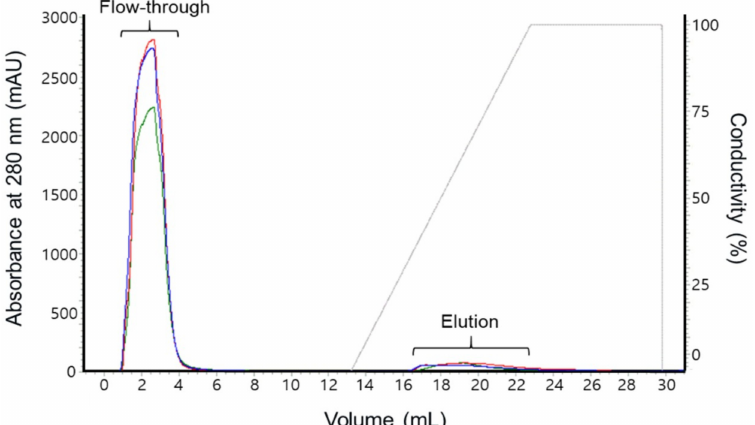
Figure 1. Chromatogram of heparin a ffi nity chromatography. The three strains of the foot-and-mouth disease virus culture supernatant were loaded onto a HiTrap HP heparin column and traced by UV monitoring at 280 nm. The chromatogram shows the fractions obtained during the purification process. The colored lines represent each as follows: blue, O / Boeun / SKR / 2017 strain; green, O / Jincheon / SKR / 2014 strain; red, Om-O-PanAsia2 recombinant strain; gray,